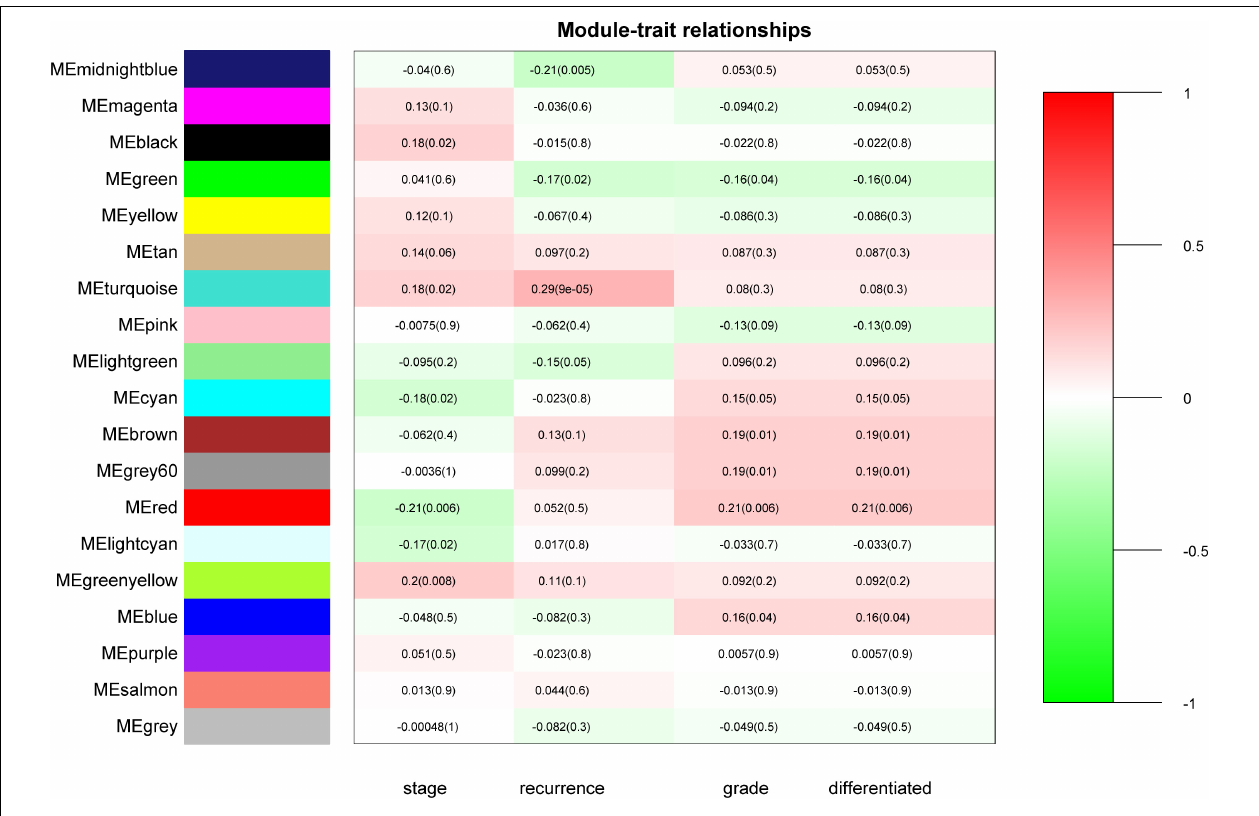
FIGURE 3 | Identification of modules associated with the clinical status of CRC. Heatmap of the correlation between module eigengenes (ME) and clinical traits of CRC. Numbers represent correlation (numbers in brackets are P -values). The turquoise module was most positively correlated with CRC recurrence.